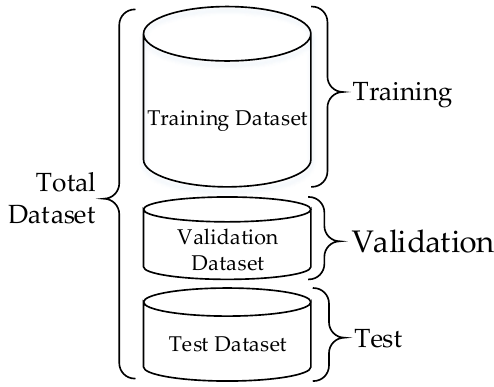
Figure 6. Holdout method for training, validation, and testing.